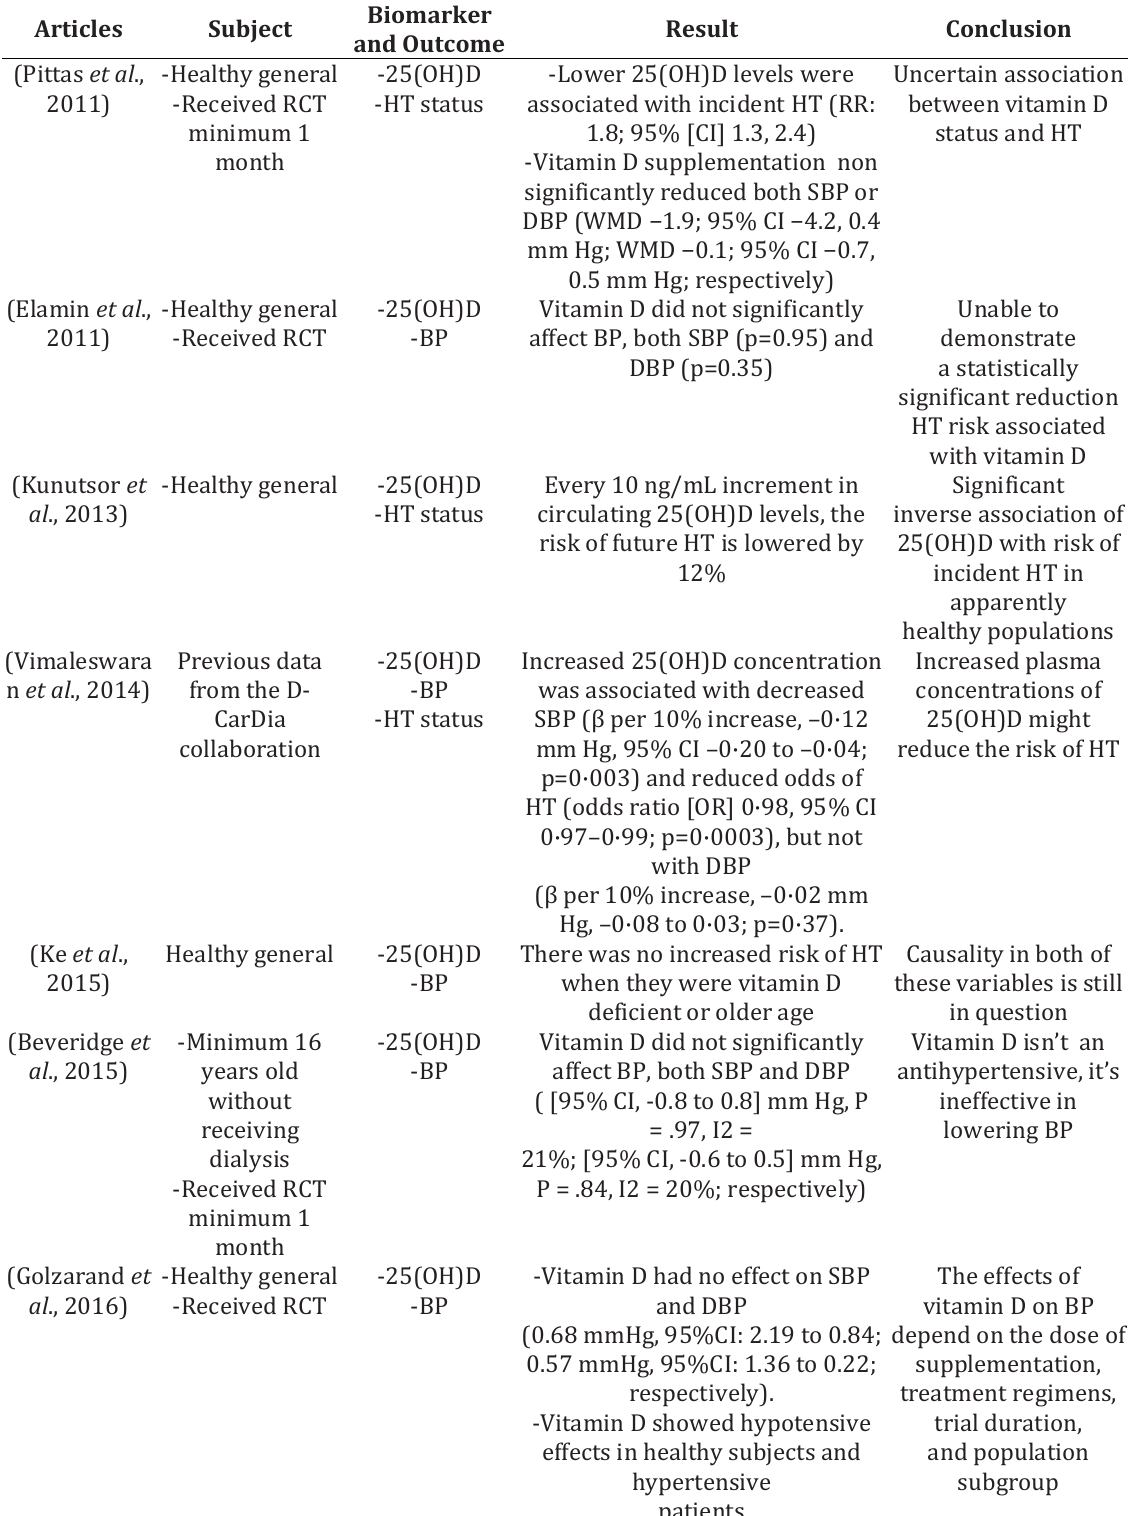
Table Ia. Summary of the Role of Vitamin D on Blood